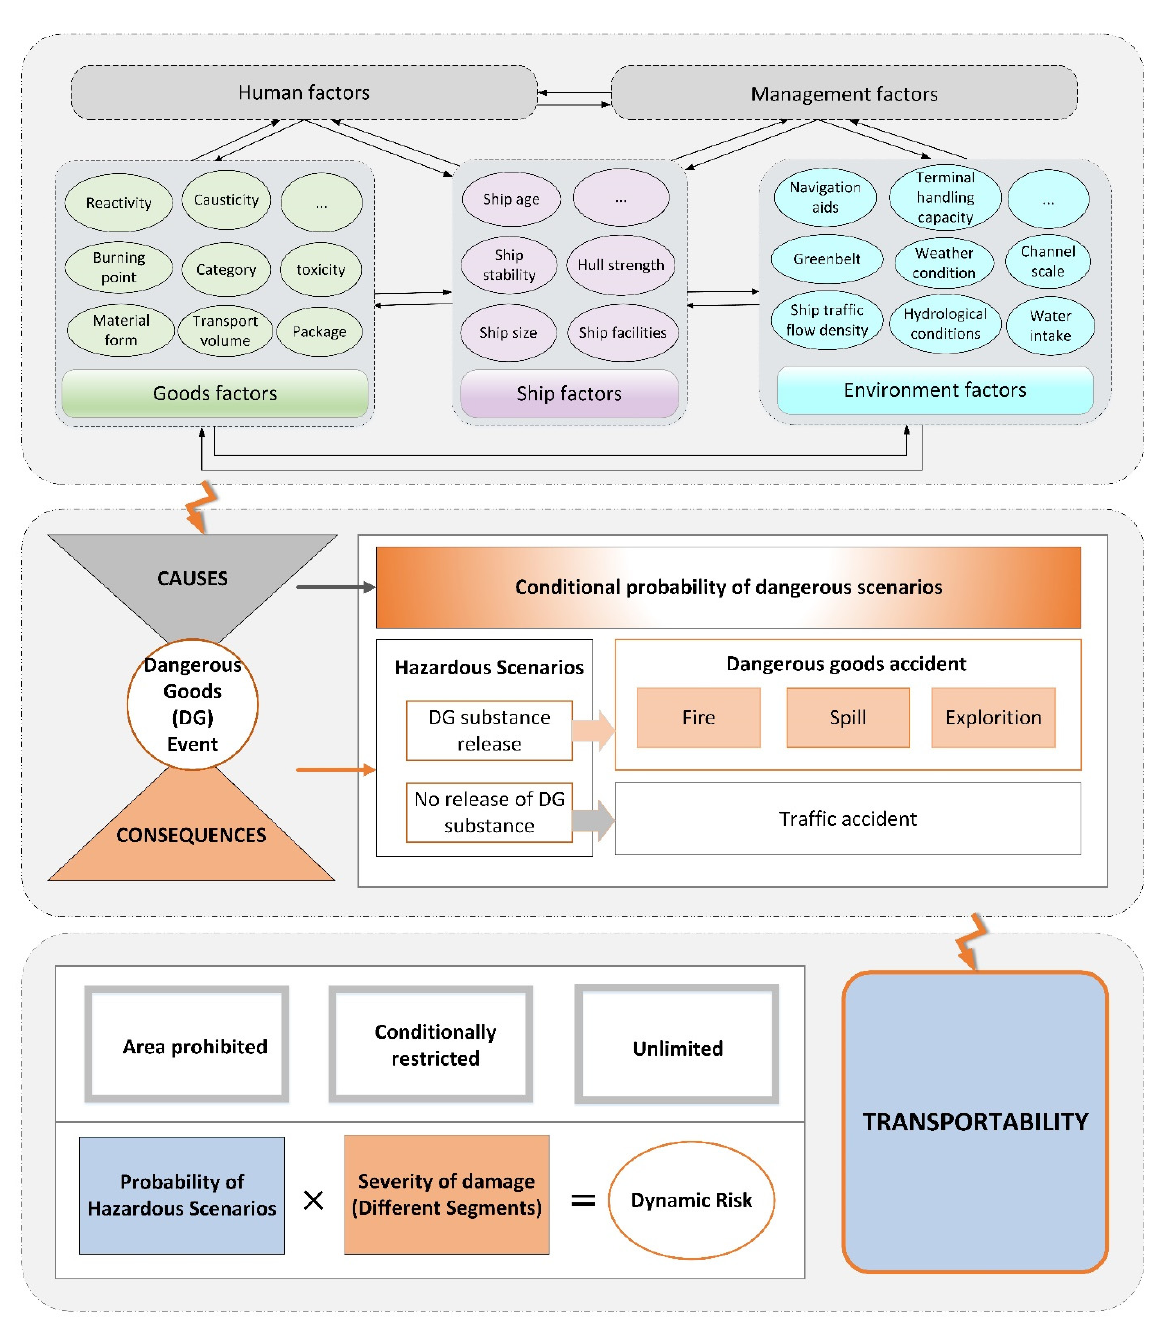
Figure 3. Schematic diagram of cause mechanism.